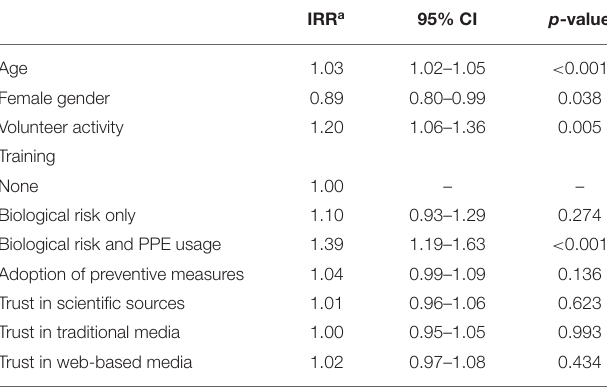
TABLE 3 | Association between independent variables and knowledge on PPE usage: results from multivariate Poisson regression